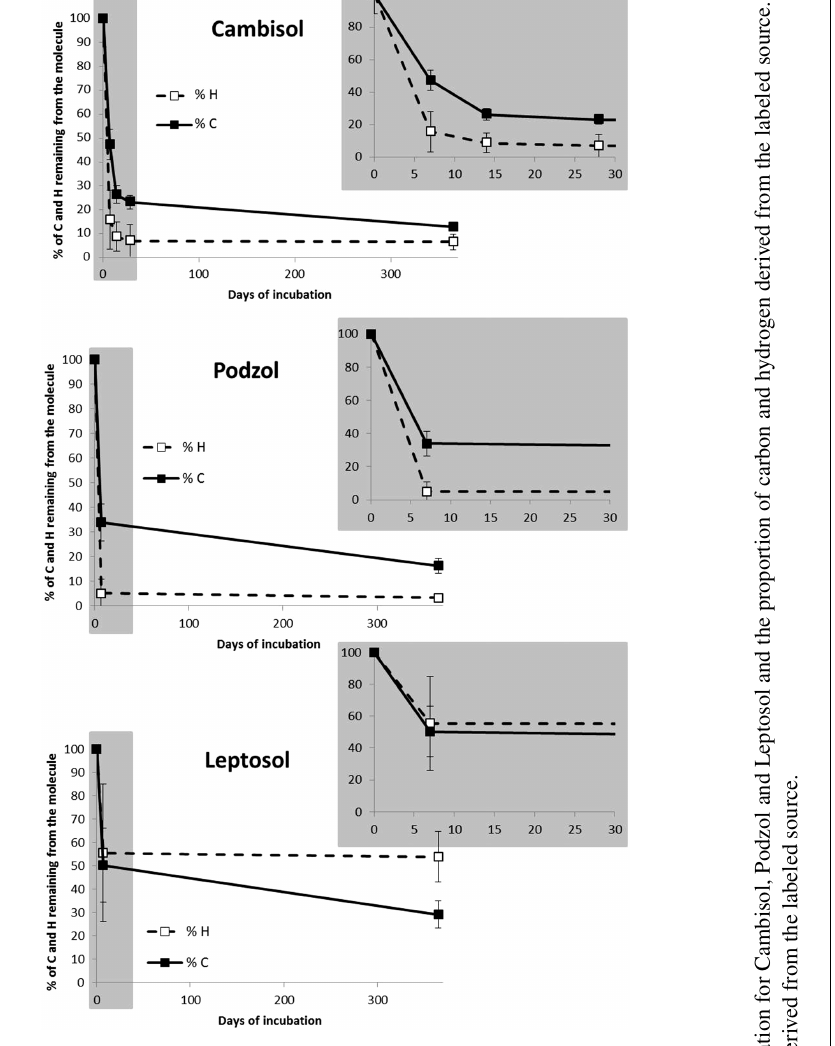
Figure 1. Percentage of non-exchangeable hydrogen (H dfm / H m · 100) and carbon (C dfm / C m · 100) remaining from the added molecule in the total soil during 1 year of incubation for Cambisol, Podzol and mollic Leptosol. The grey part corresponds to the re- sults from 0 to 28 days. The line corresponds to the mean value calculated at each time for all molecule